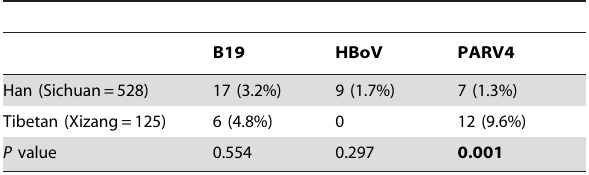
Table 3. Prevalences of B19, HBoV and PARV4 in Han and Tibetan populations in the south-western region.